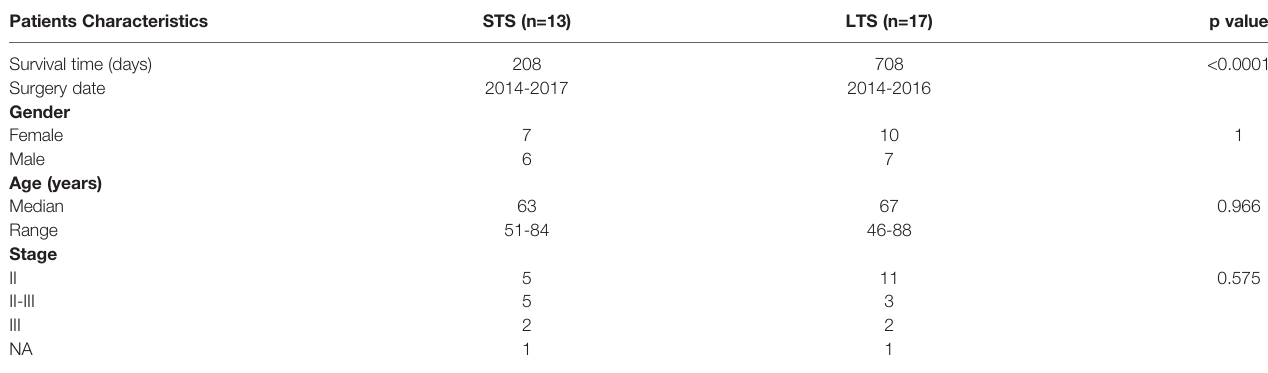
TABLE 1 | The baseline characteristics of the clinical